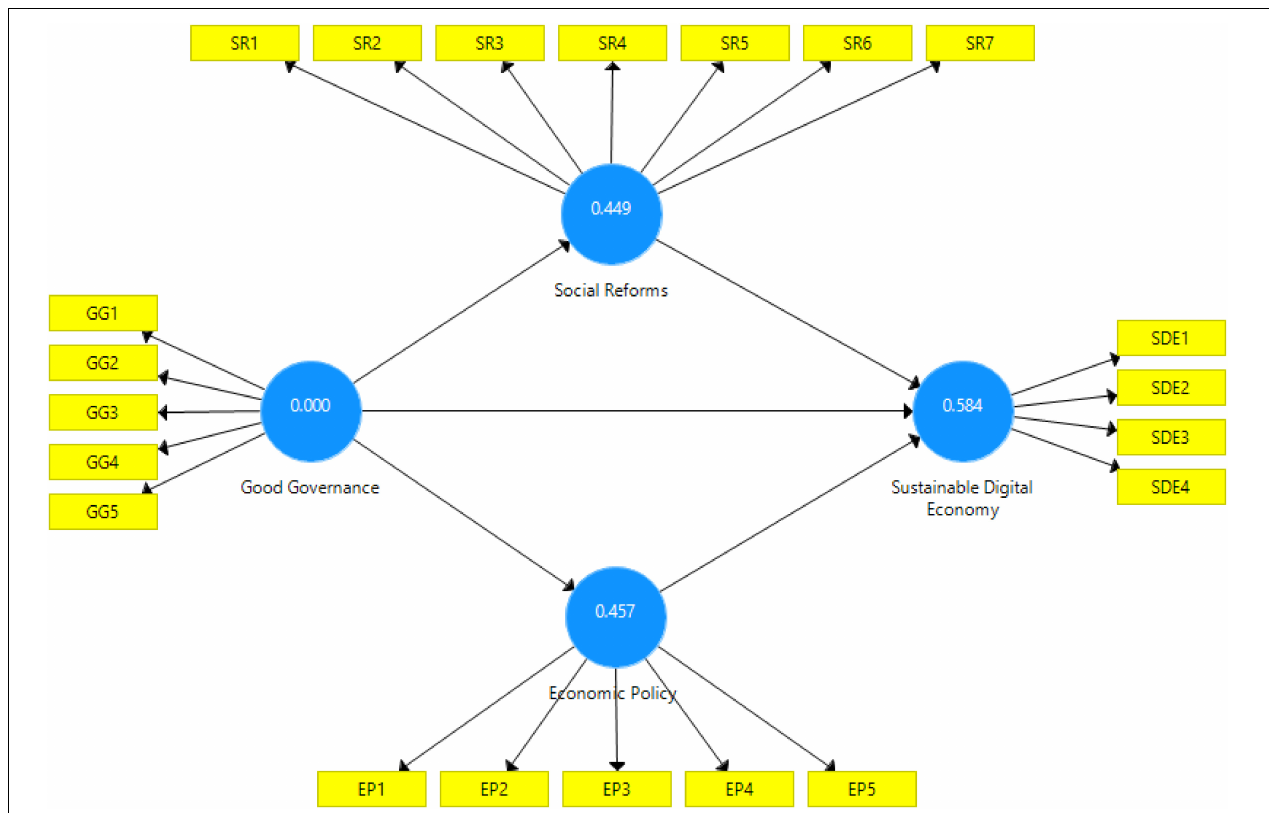
FIGURE 4 | Predictive relevance of the